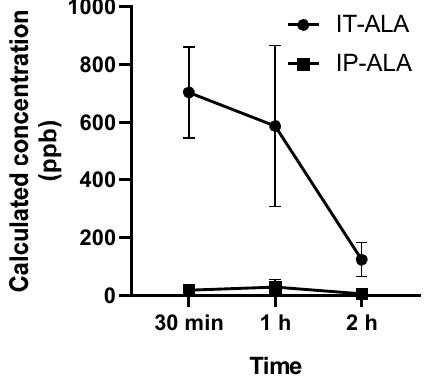
Figure 3. Perilymph concentration of ALA measured using UHPLC. The ALA concentration (parts per billion, ppb) in 3 µ L of perilymph collected from the lateral semicircular canal per billion, ppb) in 3 μ L of perilymph collected from the lateral semicircular canal demonstrated significantly higher concentration of ALA at 30 min and 1 h after the injection.